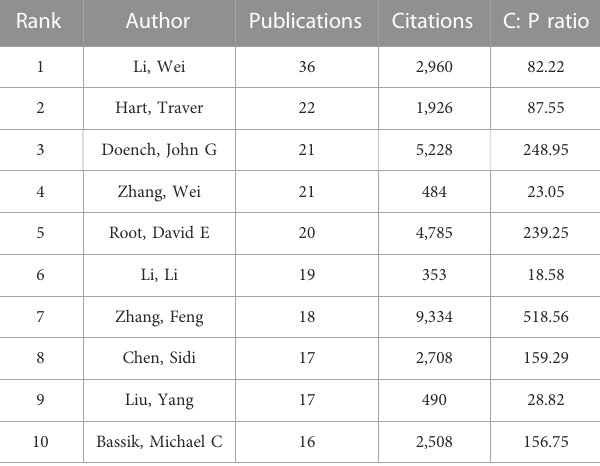
TABLE 1 The top 10 most productive authors related to CRISPR in